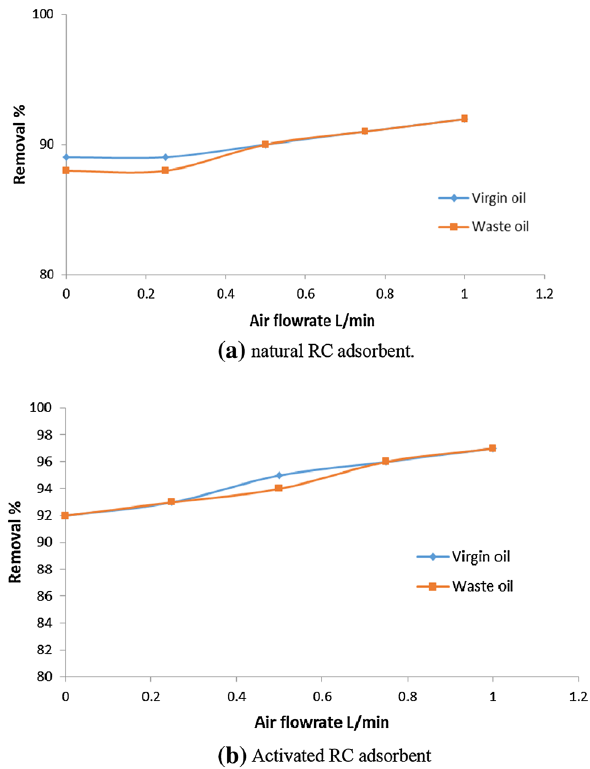
Fig. 9 Oil removal efficiency at different air flow rate by RC adsor- bent